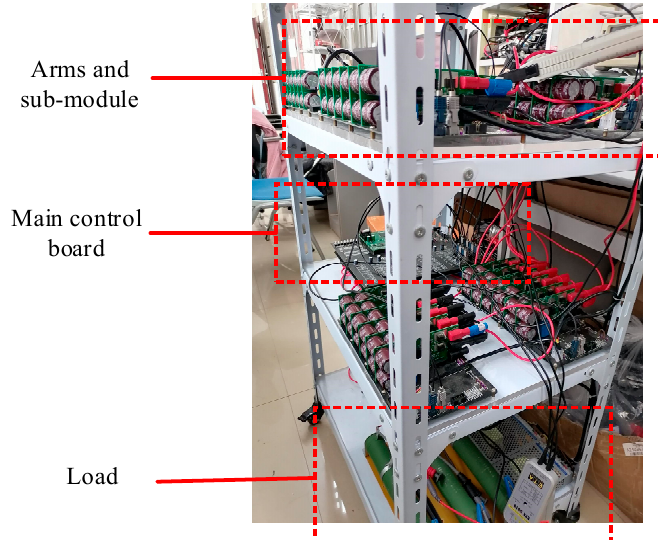
Figure 10. MMC experimental prototype based on DSP-FPGA.